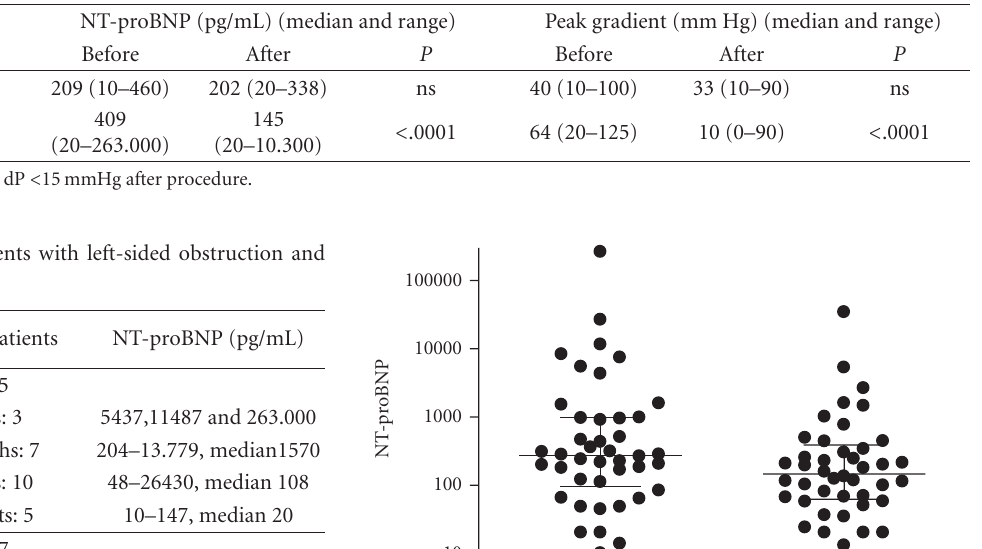
Table 3: Change of NT-proBNP concentrations (pg/mL) before and after intervention.